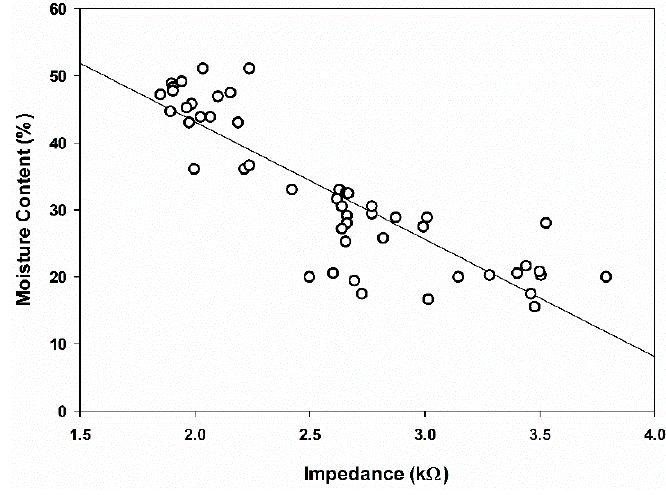
Figure 4. Effect of moisture content on the impedance value at 100 kHz. Table 4. Correlation coefficient ( r ) of impedance with moisture and oil content at four frequencies using the Pearson correlation